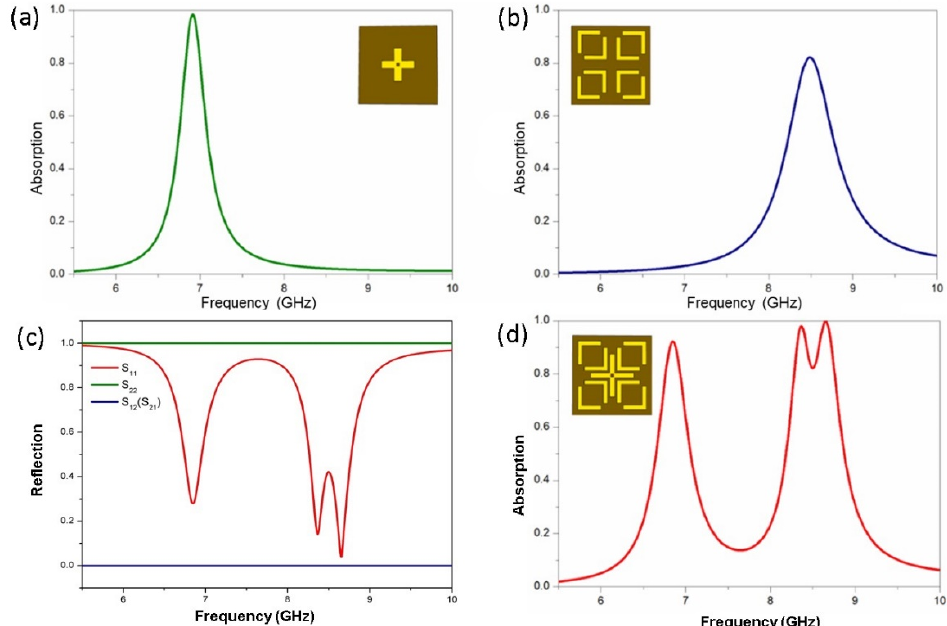
Figure 2. Absorption spectrum of ( a ) CS structure and ( b ) SRR one. ( c ) Parameters S 11 , S 22 and S 12 ( S 21 ), and ( d ) absorption spectrum of the proposed MA.